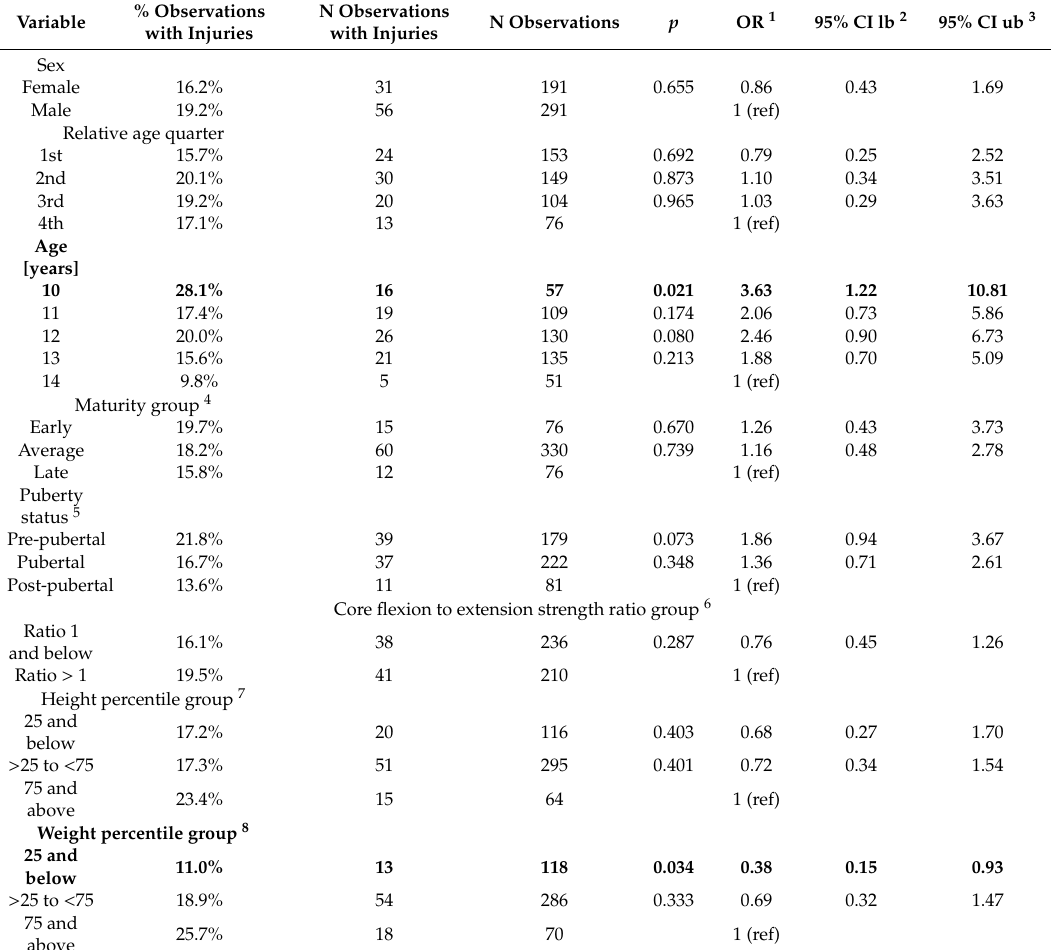
Table 2. Potential factors associated with traumatic injuries according to the simple general estimating equation analysis ( n = 482 observations).